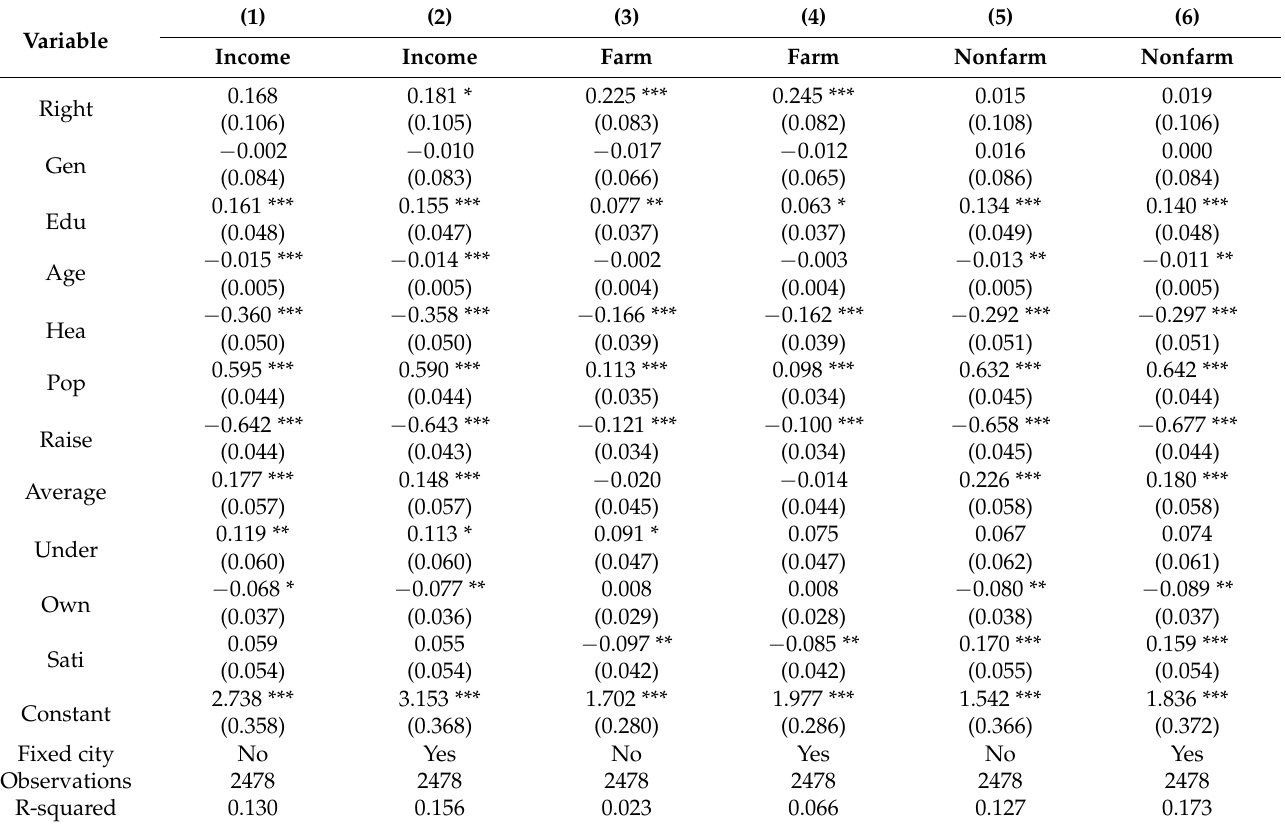
Table 4. Benchmark estimation results of rural land right on farmers’